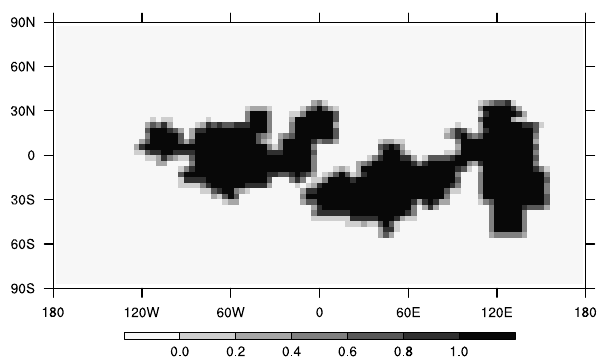
Fig. 1. Marinoan land-sea mask. Values of 1 correspond to pure land points, values of 0 to pure ocean points. Mixed grid boxes with land and ocean cover occur at the continental edges.